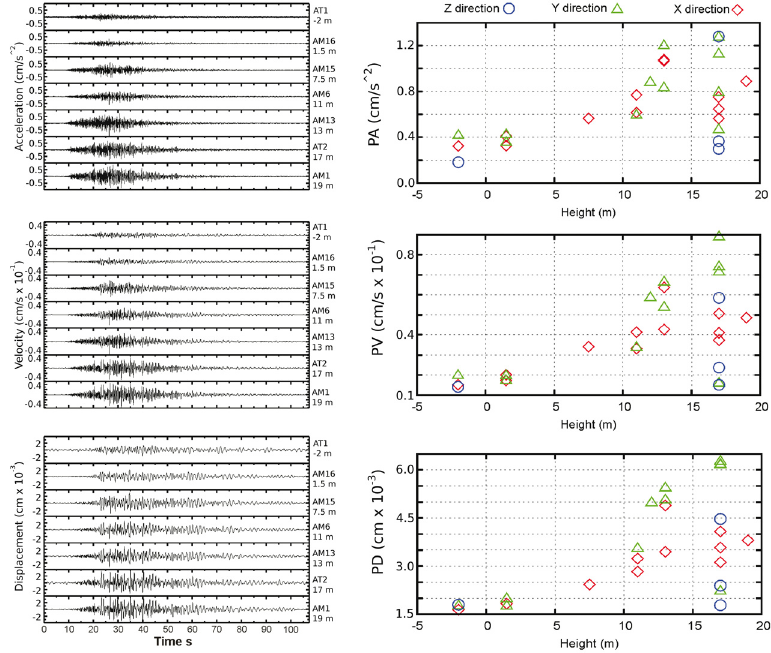
Figure 9b. Earthquake of 16 th February 2013 (M 4.8). Left panel: Acceleration, velocity and displacement of some stations at increasing el- evation (the name of station with elevation is also indicated in the graphs). Right panel: PA, PV and PD versus the station elevation for the three components of motion.